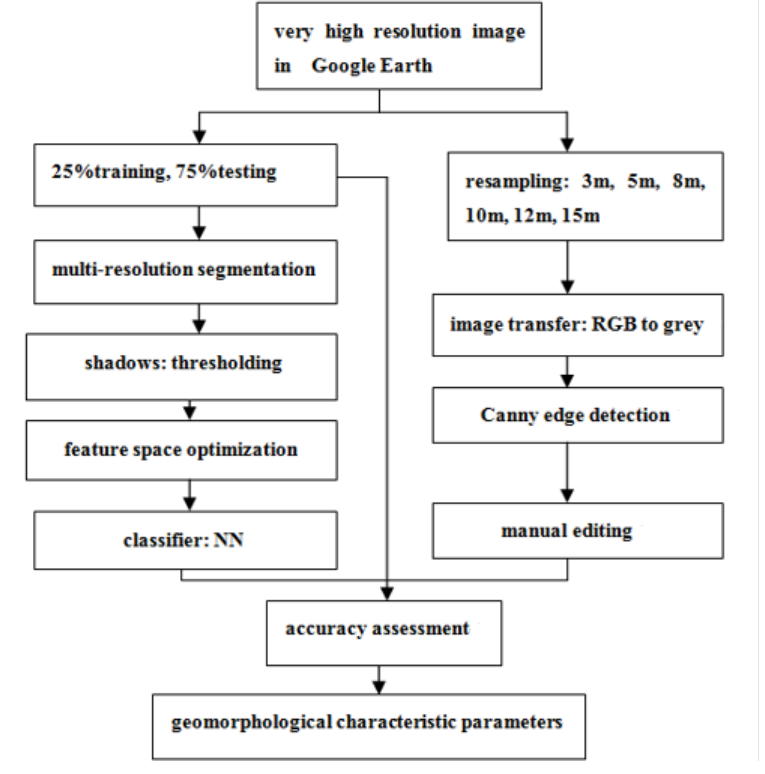
Figure 2. Overview of the